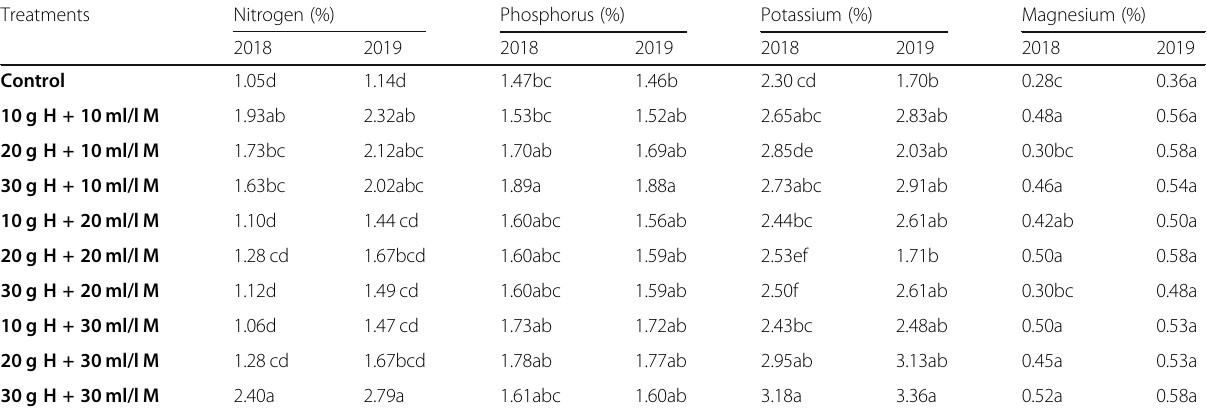
Table 4 Effect of soil application with humic acid and foliar spray of milagro on some leaf macro element contents Treatments